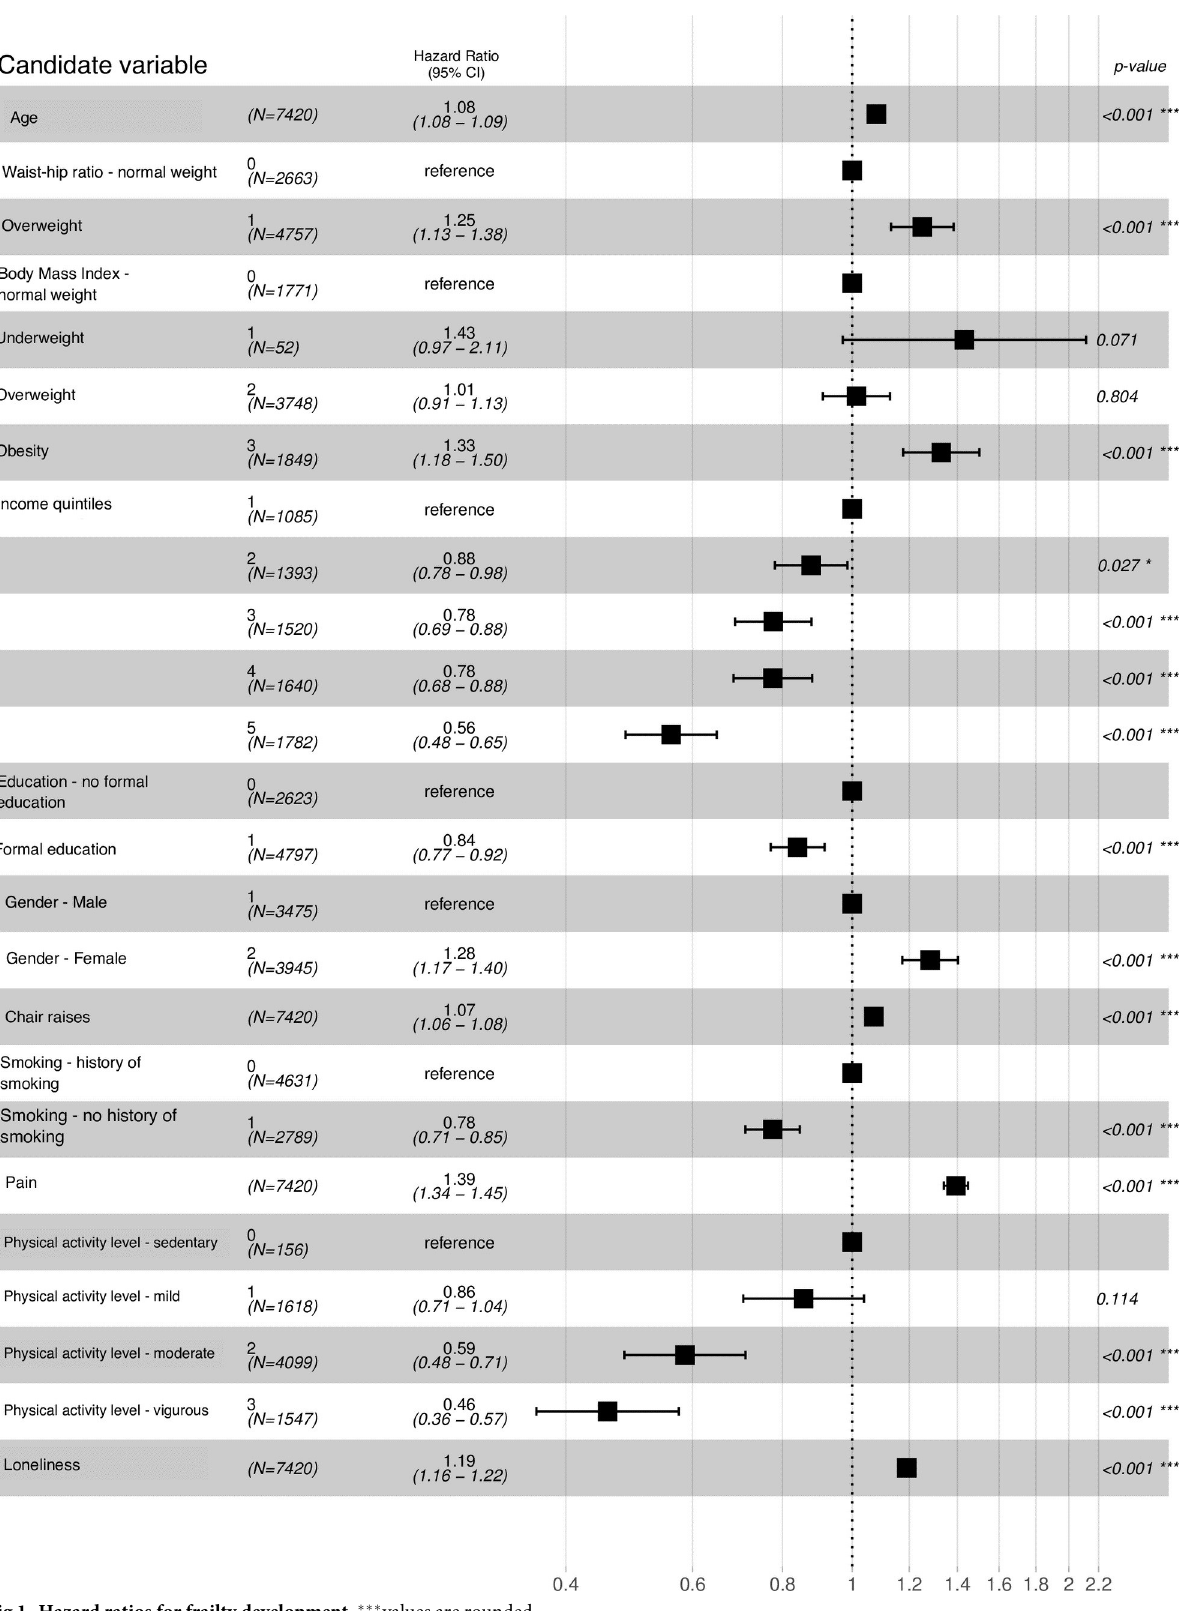
Fig 1. Hazard ratios for frailty development. ��� values are